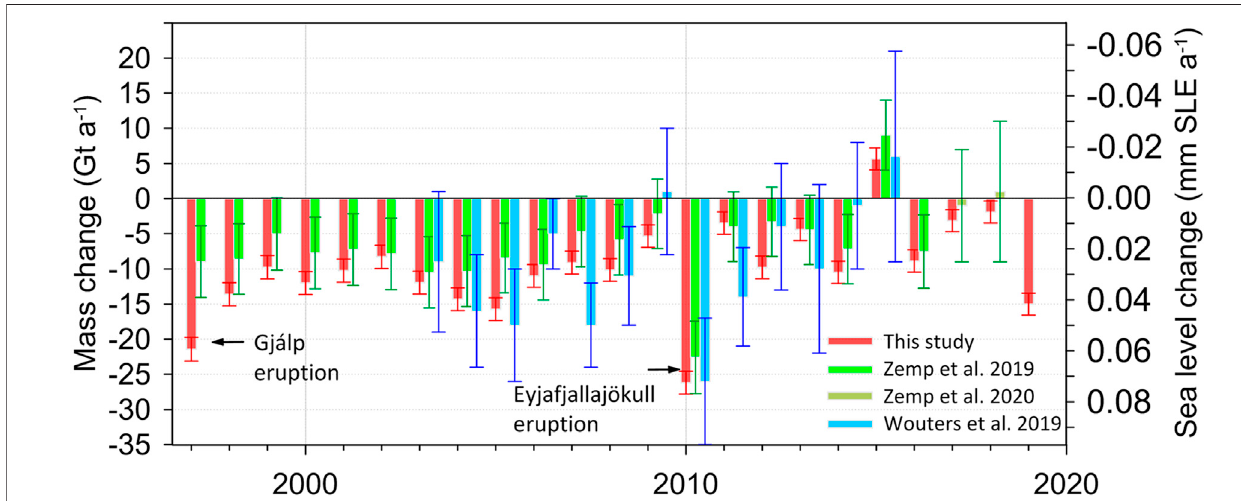
FIGURE 6 | Comparison of mass change rates estimated in this study and studies based on glaciological observations provided to the WGMS database (Zemp et al.,2019;Zempetal.,2020b)and theGRACEobservations(Wouters etal.,2019),withtherespectiveestimateduncertainties.The fi gureshowsonly theperiod when Vatnajökull, Hofsjökull, and Langjökull have all been monitored with glaciological observations. The contribution of other glaciers is from geodetic results (Belart et al., 2020), including an estimated annual variability (see Section 2 ).